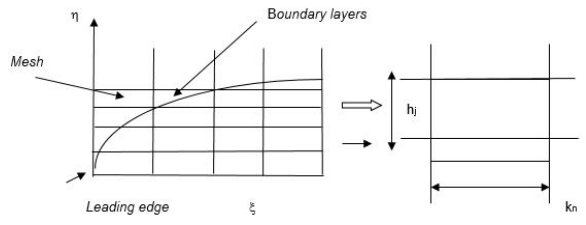
Fig. 2: Keller Box element and boundary layer